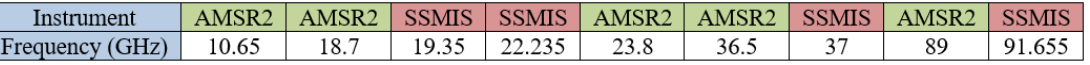
Figure 8. GPM-Intercalibrated SSMIS and AMSR2